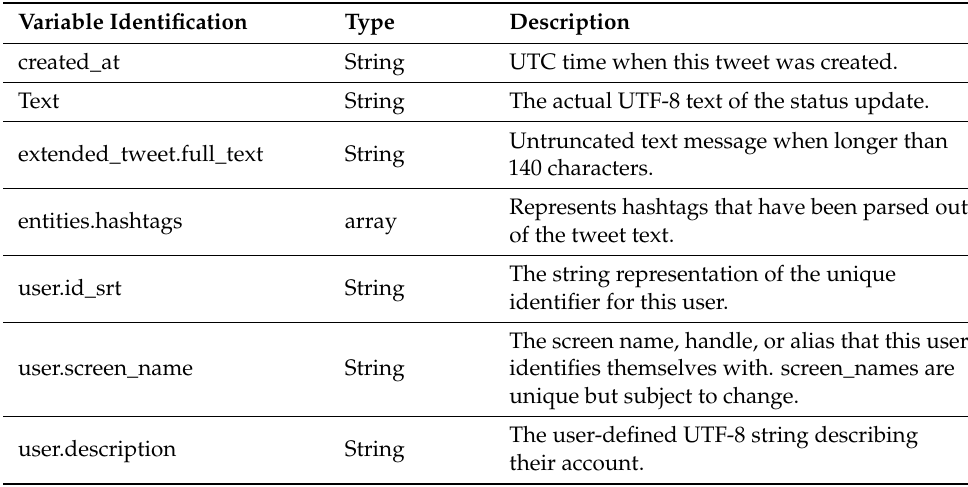
Table 1. Used data fields in the analysis. (Twitter API JSON